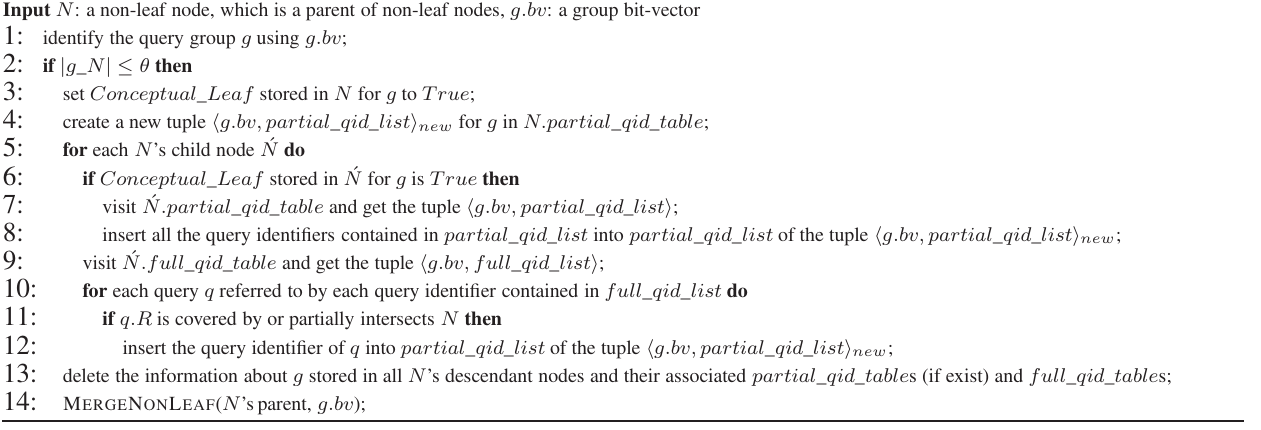
Algorithm 7 M ERGE N ON L EAF ( N, g.bv )